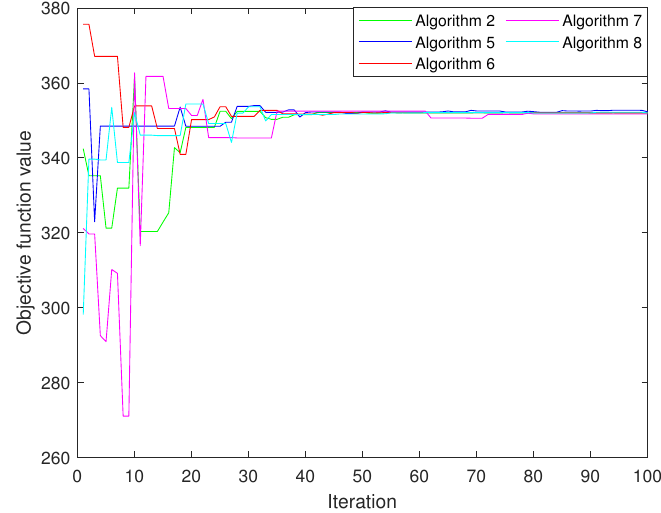
Figure 6. Comparsion of algorithms in three dimensions.